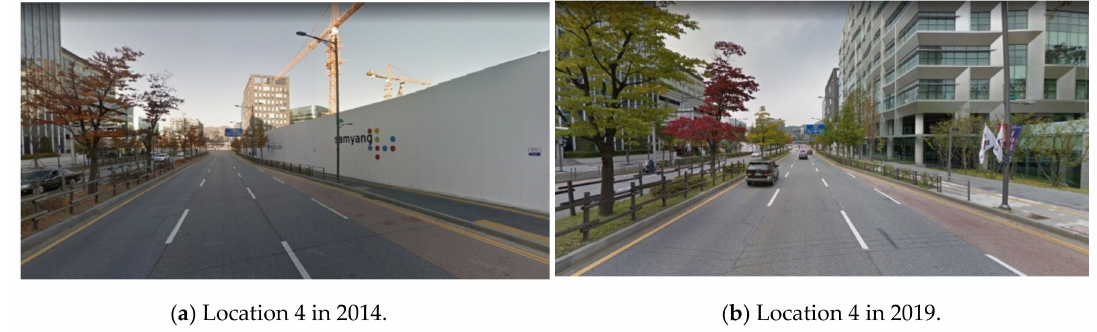
Figure 16. New building found at location 4 (Naver Maps [33]).